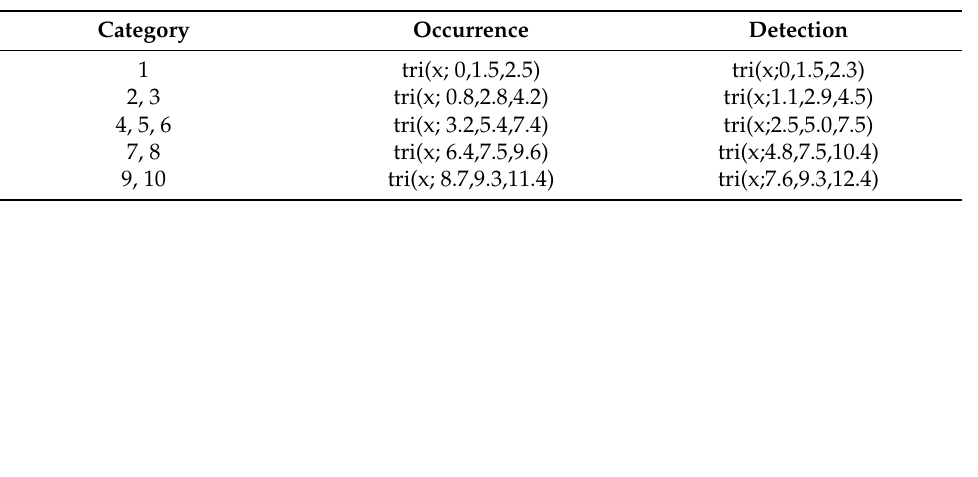
Table 6. Type-I triangular membership functions for the FMECA risk